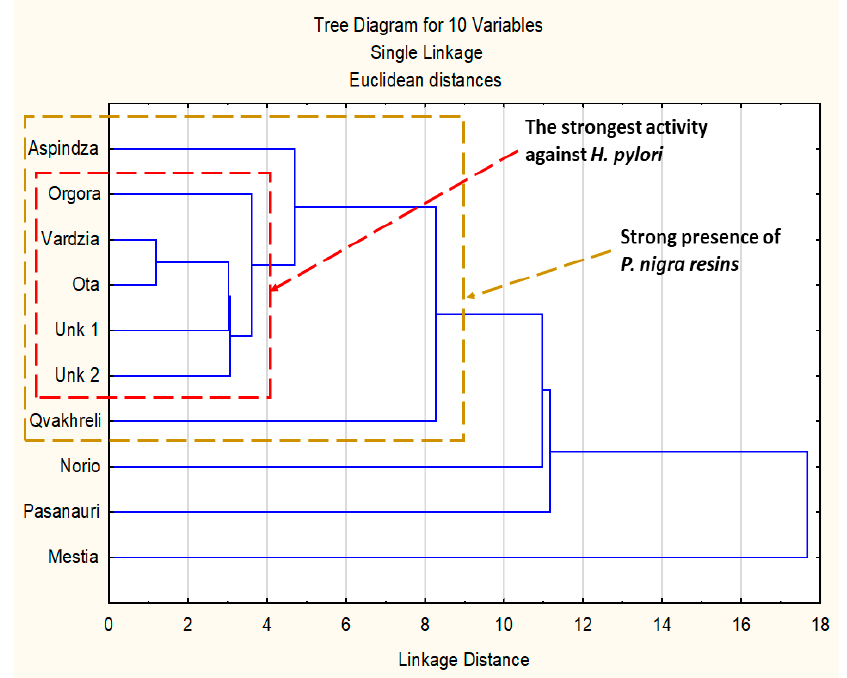
Figure 4. Hierarchical fuzzy clustering analysis presented as a dendrogram.